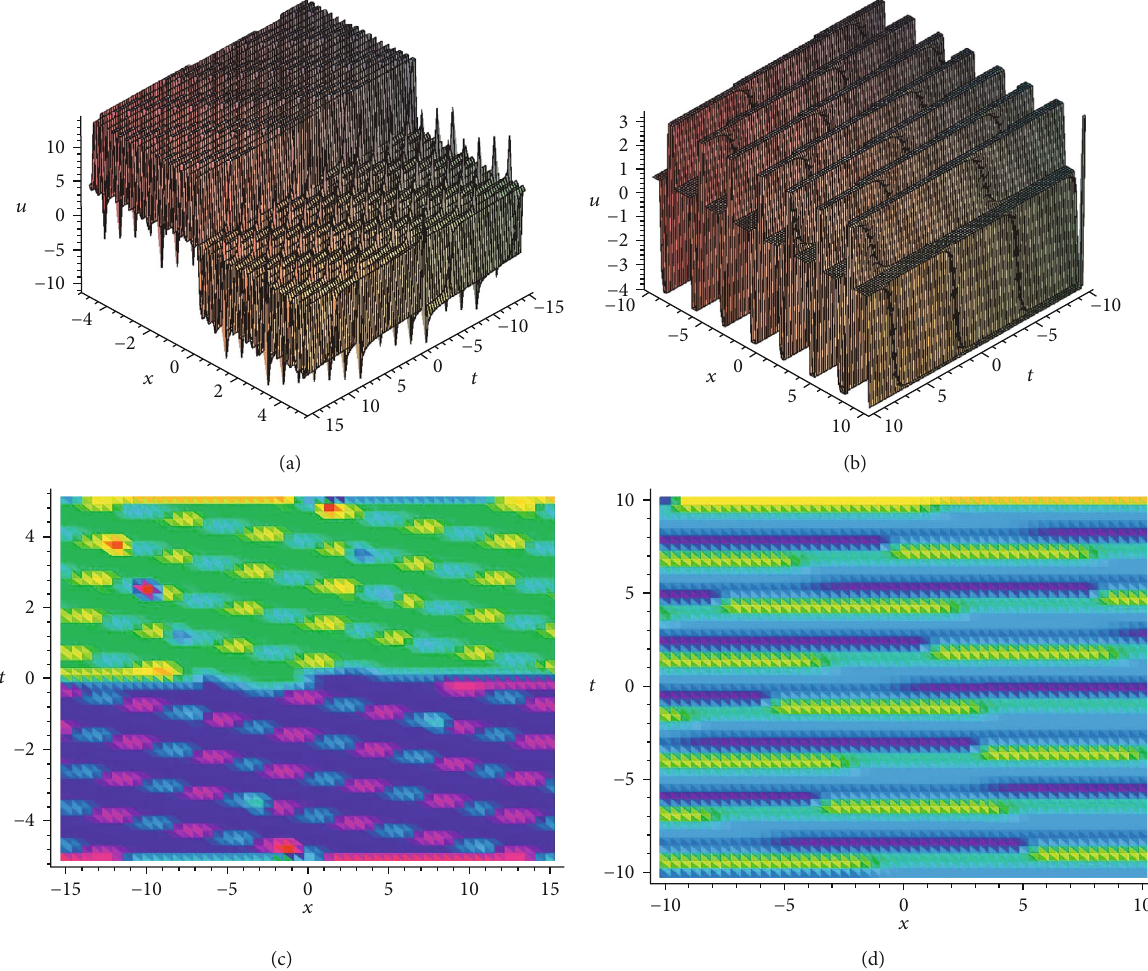
Figure 5: (a) The interaction solution between soliton and sine-cosine wave of u in equation (29) by substituting (27) and (31), with parameters: { a 1 = 1/3, a 2 = 1/3, c 1 = − 6, k 1 = 1/4, k 2 = 1/4, l 1 = 3/20, l 2 = 3/20 }. (b) The interaction solution between soliton-cnoidal wave of u in equation (29) by substituting (27) and (32), with parameters: { μ = 50, k 1 = 1/4, l 1 = − 1, l 2 = 0 : 37, c 1 = 2/3, m = 0 : 7 }. (c) and (d) are the overhead view of the wave (a) and (b).This interaction solution re fl ects the elastic